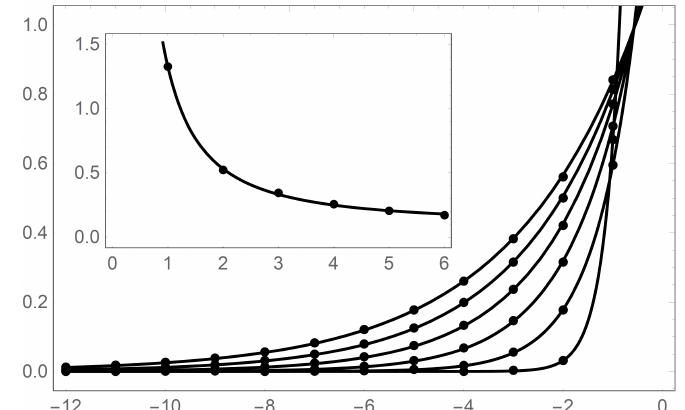
Figure 11. The primary plot is the radial distance of the fixed points as a function of θ . Pictured are six exponential line plots corresponding to k values 1–6, with k = 1 being the right most curve. The value of k increase as the curves sequentially move leftward. The ordinate displays the distance from the origin the fixed point is located (assigned variable d ). The abscissa displays θ = 10 x . The points on the primary plot can be fit with the function d = A 10 ax . The inset plot displays the exponent fit parameter a (ordinate) as a function of k (abscissa). These points are fit with a line from the equation a = 1.230 Primary plot fit parameters ( k , a , A ) : ( 1,1.325,14.172 ) , ( 2,0.521,1.978 ) , ( 3,0.344,1.561 ) , ( 4,0.256,1.389 ) , ( 5,0.204,1.295 ) , ( 6,0.169,1.237 )